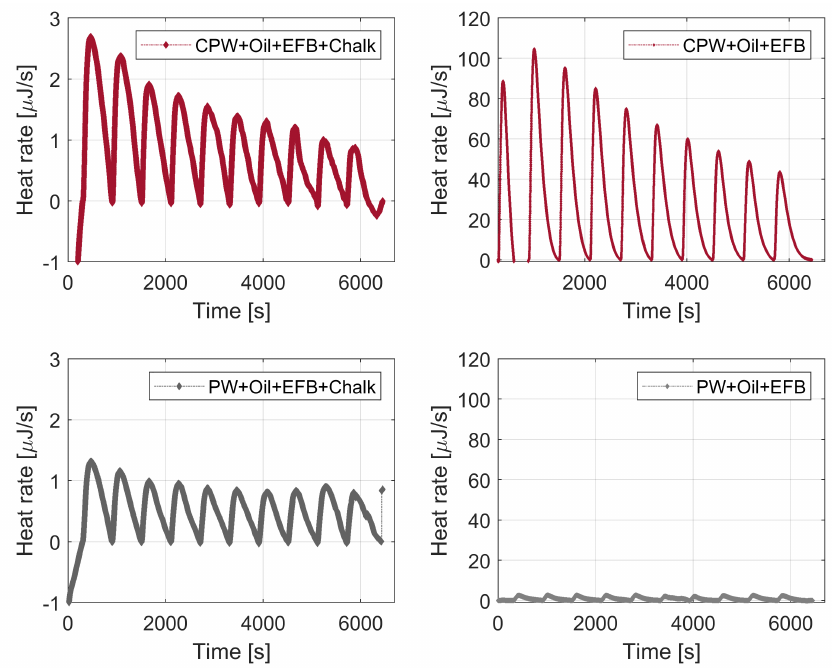
Figure 3. Heat rate versus time for carbonated produced water and produced water titrated into the system of oil, Ekofisk brine and